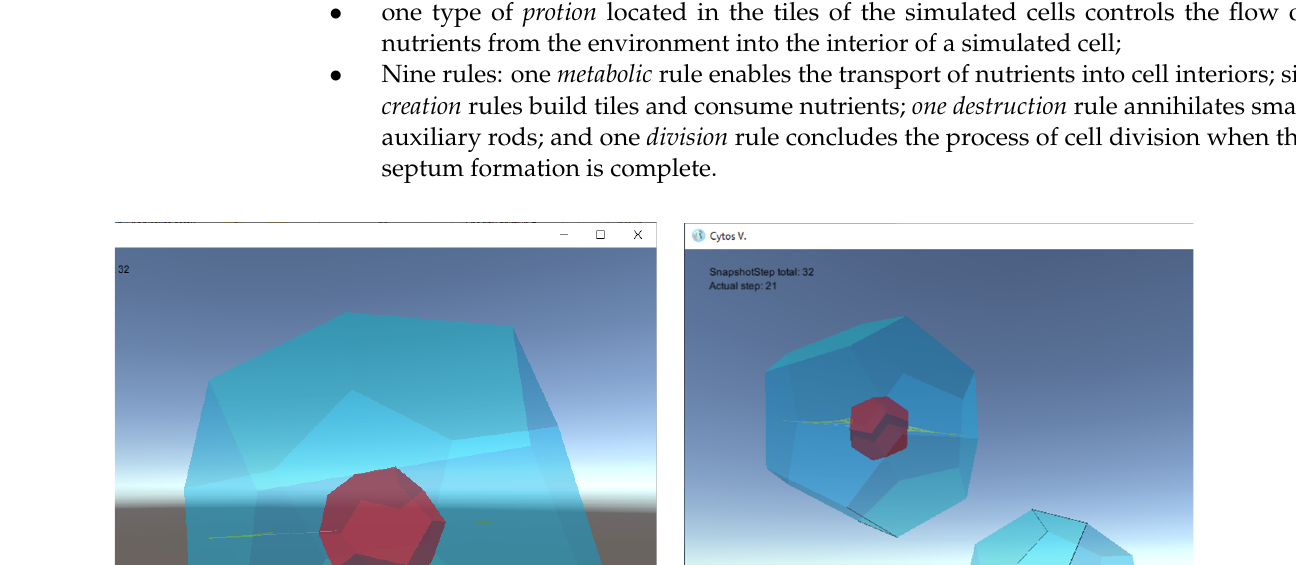
Figure 1. Snapshots of an M system (M 0 ) modeling eukaryotic cell membrane (in blue), cytoskeleton and nuclear membrane (in red) formation ( a ), as well as mitosis ( b ) [18,25].